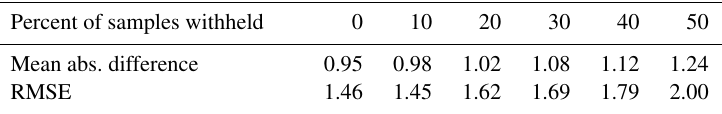
Table A1. Mean absolute difference and RMSE for different reductions of the original training dataset. The test was performed on training sets for five different OMI rows, and the errors were averaged.